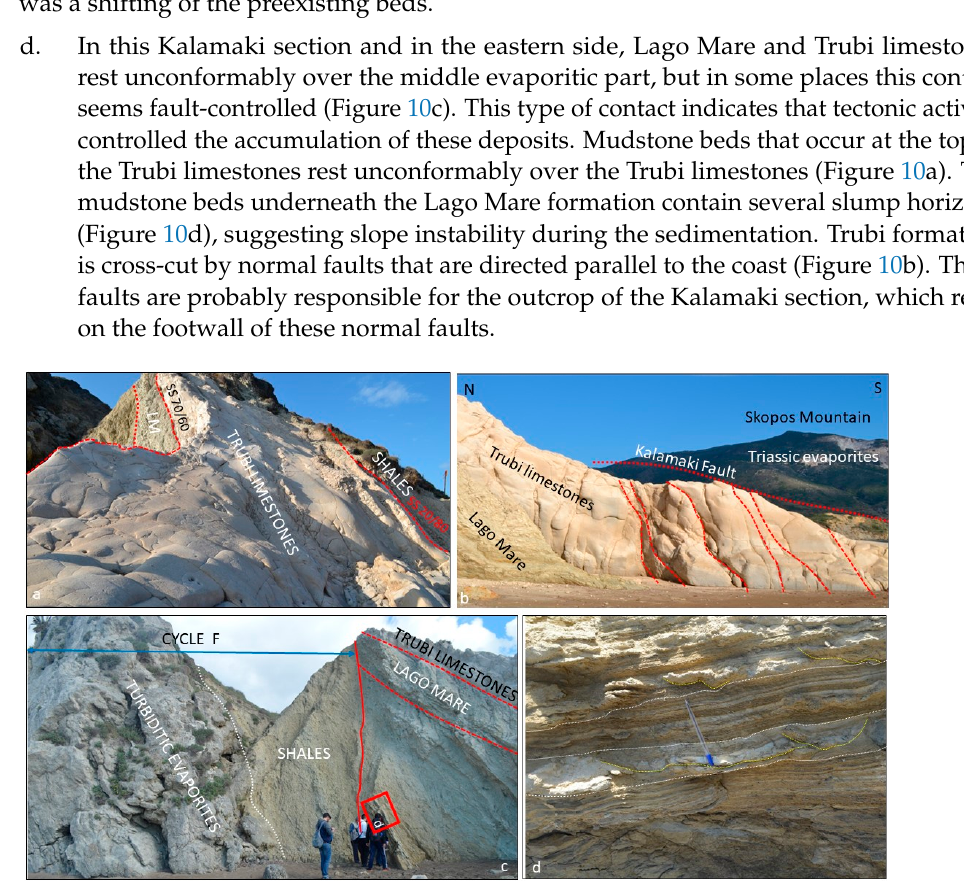
Figure 10. ( a ) View of Trubi limestones with bed direction and the contact with the overlying shales. See the great difference between them in bed directions. ( b ) Lago Mare and Trubi limestones in contact. See the faults that cross-cut the Trubi limestones. In this figure, it is marked the position of Kalamaki fault and the Skopos Mountain with the Triassic evaporites. ( c ) See both the-fault controlled and unconformity contact between the upper part of turbiditic evaporites and Lago Mare and Trubi limestones. ( d ) Strong deformation internally to the beds under the Lago Mare deposits.